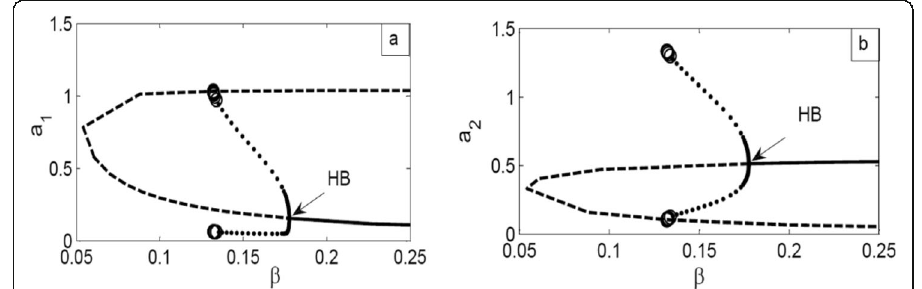
Fig. 13 Bifurcation diagram of feedback signal gain β as the bifurcation parameter